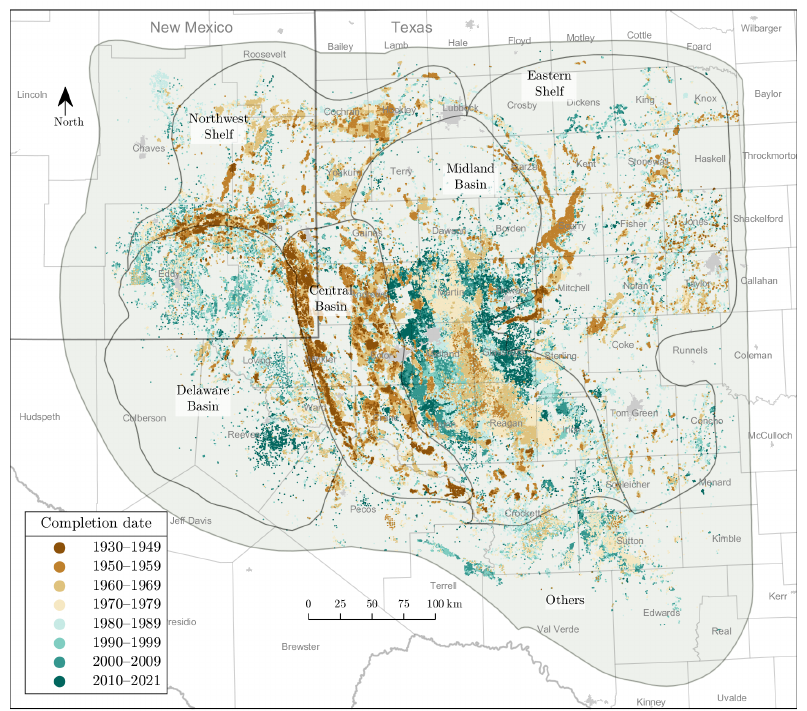
Figure 2. The map of all 484,759 vertical wells in the Permian Basin, colored by completion date.